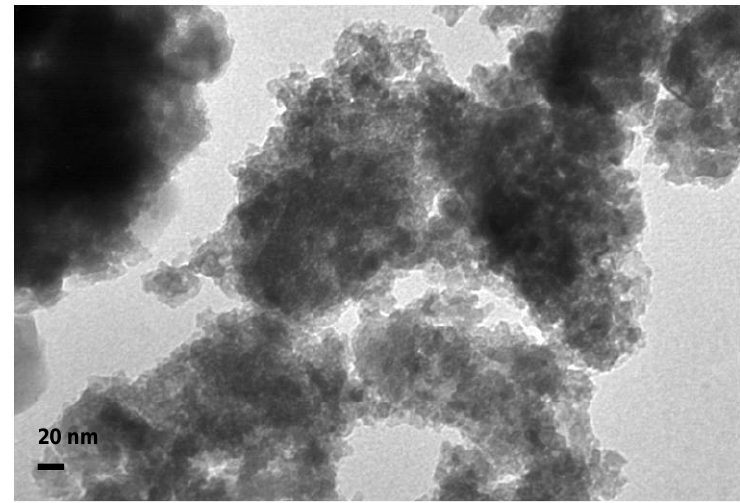
Figure A5. Microphotography of Ru/Al 2 O 3 -Na(10 wt%) catalyst.